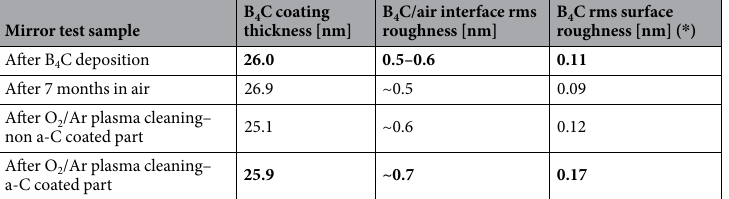
Table 3. Results from the IMD simulations of the XRR measurements as shown in Fig. 2 (bottom rows) as well as from reference measurements of non-processed samples (top rows). ( * )Surface roughness values from interference microscopy.